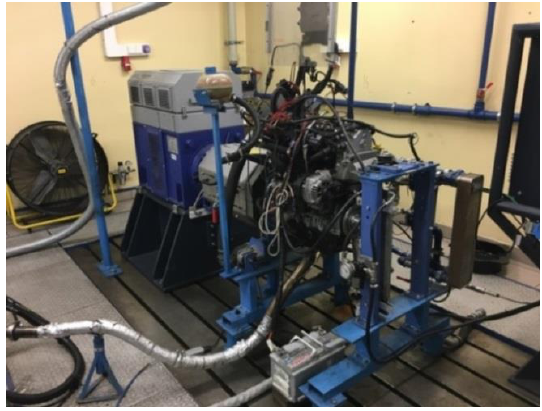
Figure 2. Object of the investigations on an engine test bed.